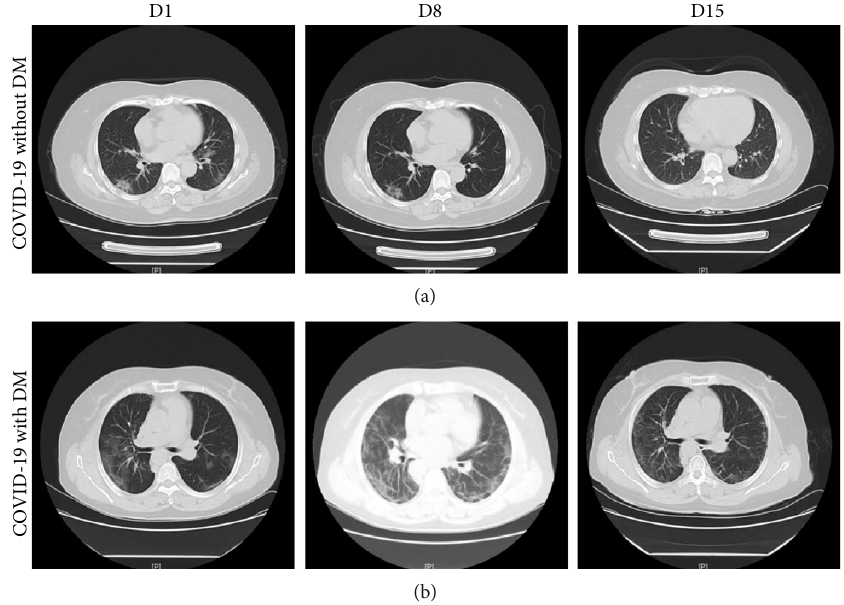
Figure 1: Representative chest computed tomography (CT) images of COVID-19 pneumonia in a nondiabetes mellitus (DM) case and a DM case. (a) A 54-year-old woman with COVID-19, but not DM: chest CT images showed ground-glass opacity (GGO) and patchy